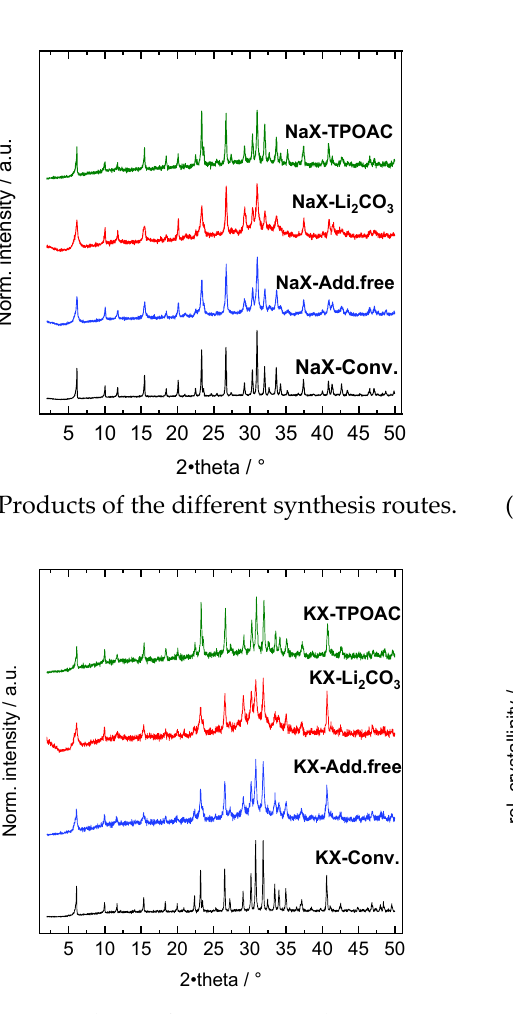
( d ) Crystallinity in dependence of K·Al − 1 . Figure 1. XRD patterns of ( a ) NaX after drying and, in the case of NaX-TPOAC, also calcination; ( b ) Zeolite X samples after the first ion exchange; ( c ) KX obtained after the sixth ion exchange and; ( d ) relative crystallinities from XRD in dependence of potassium to aluminium molar ratio (after subsequent ion-exchange steps) of the layer-like and conventional zeolite X samples.